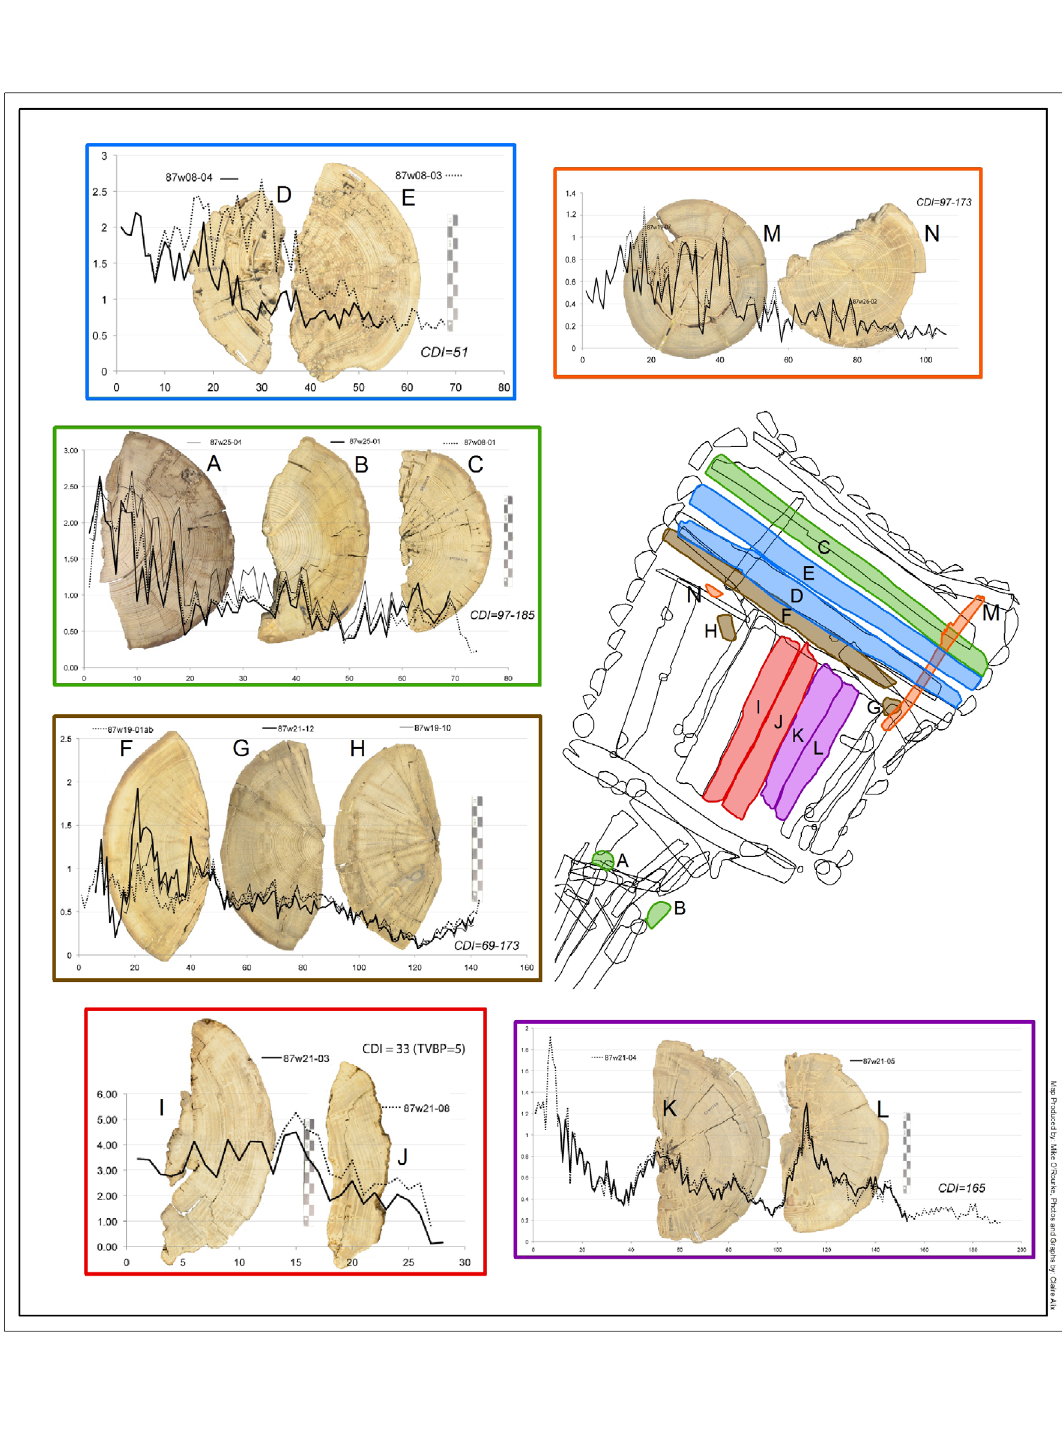
Figure 4: Crossdating of wood samples across the house. Tree-ring sequences are in raw ring width (in hundredth of mm). CDI=Cross Dating